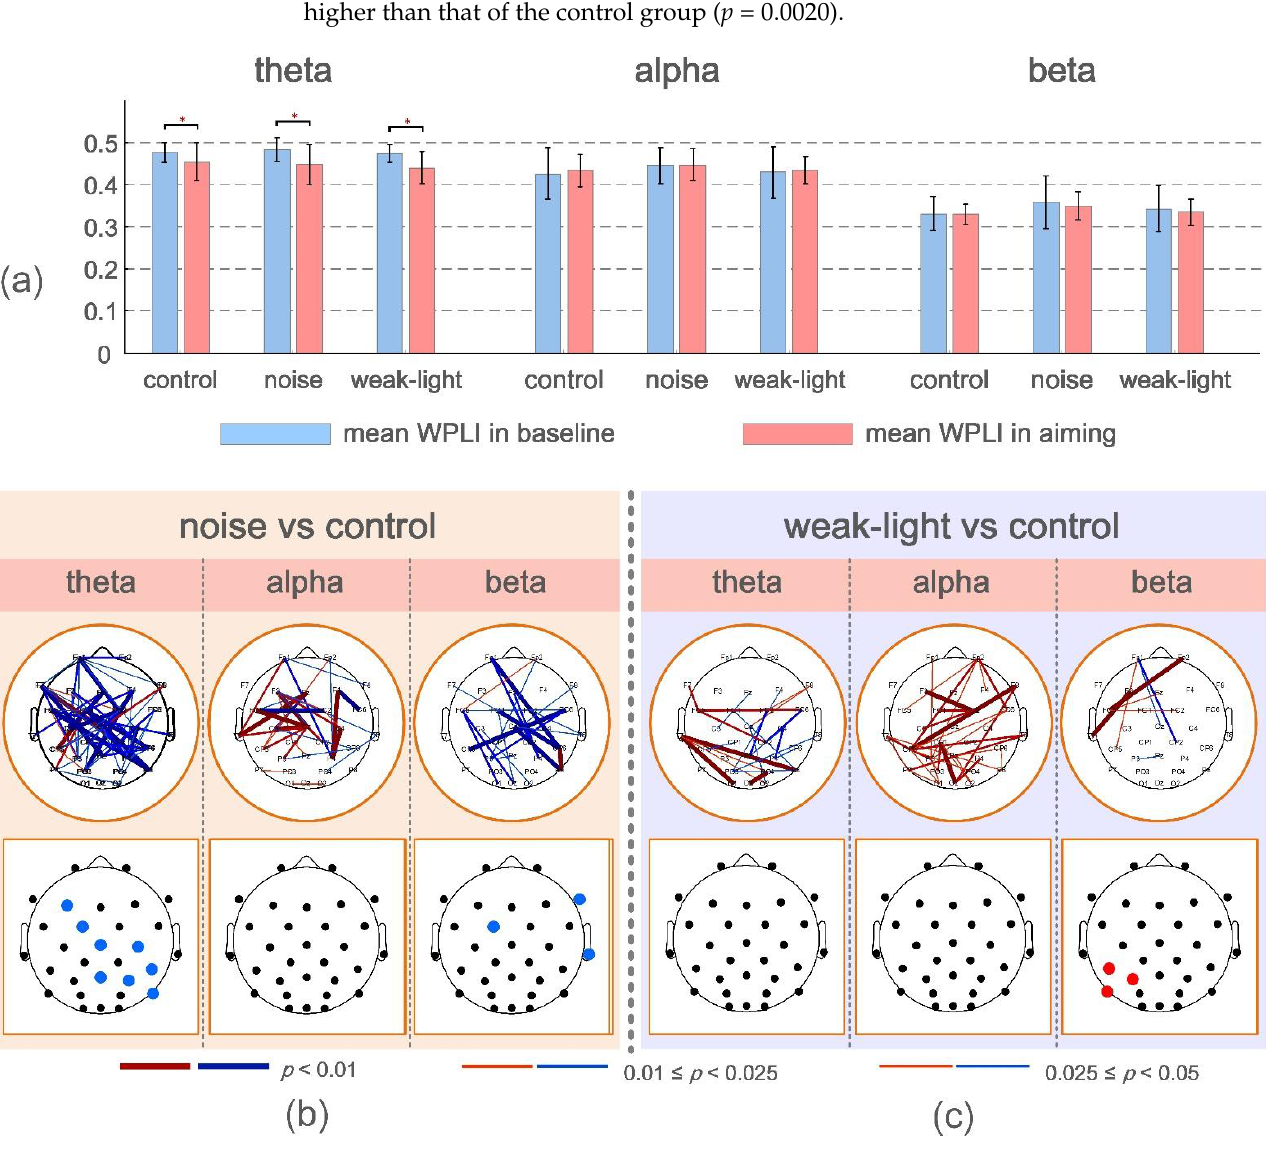
Figure 3. ( a ) Mean and standard deviation of the mean WPLI values at baseline and during aiming for the three conditions. * p < 0.05 indicates a significant difference. ( b , c ) Connections and nodes with significant differences in ERWPLI in theta, alpha, and beta bands between the noise, the weak-light, and the control groups. Red/blue indicates that the ERWPLI of the noise and the weak-light groups was higher/lower than that of the control group.